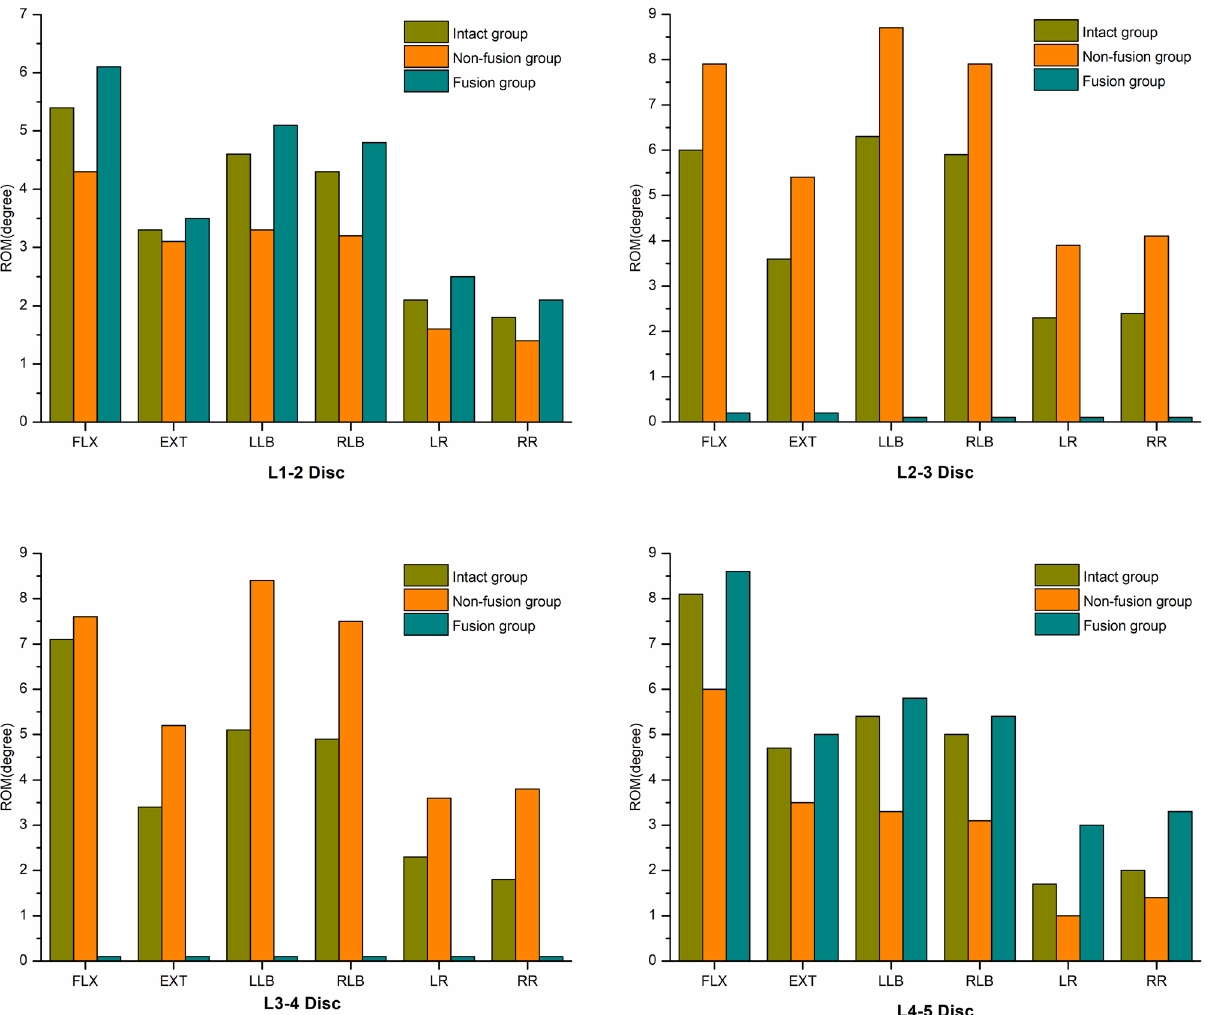
Figure 2. Comparison of disc ROMs among different groups in flexion, extension, left lateral bending, right lateral bending, left rotation and right